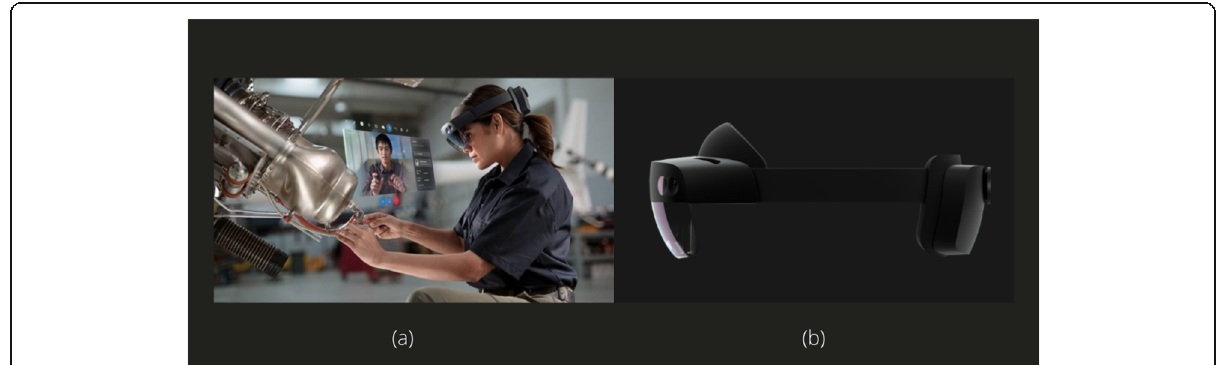
Fig. 15 Dynamic 365 remote assist on Microsoft Hololens 2 AR